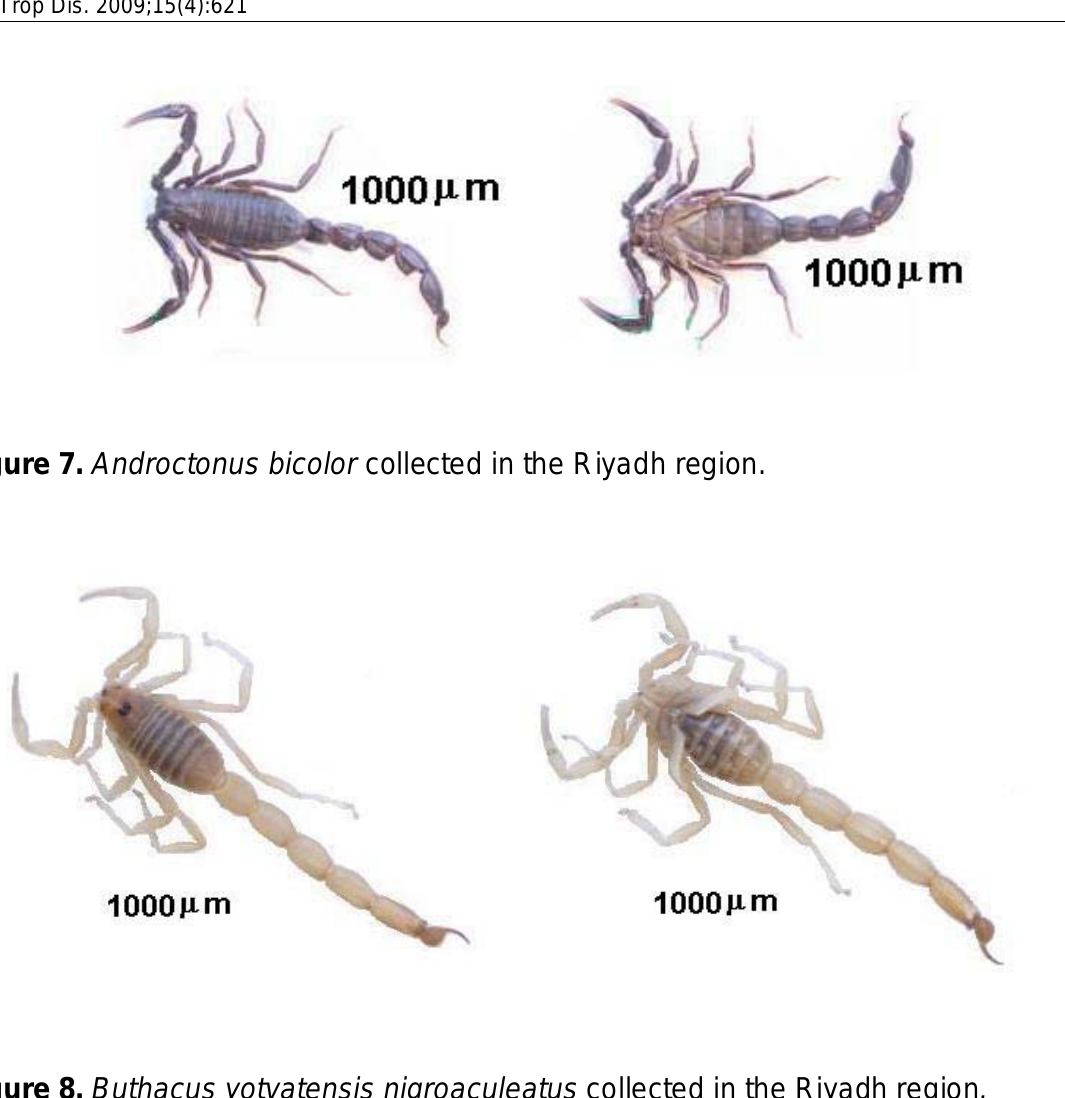
Figure 8. Buthacus yotvatensis nigroaculeatus collected in the Riyadh region .